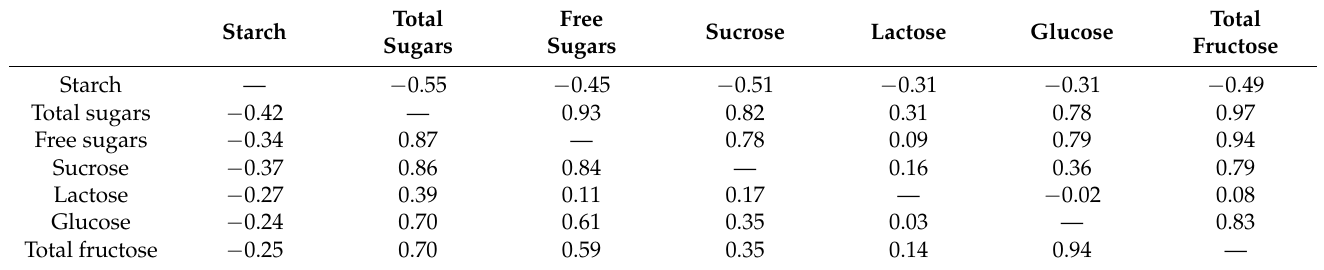
Table 2. Pearson’s correlation coefficients among the intakes of starch and sugars in 3963 young (above diagonal) and 3826 middle-aged (below diagonal) Japanese women 1,2